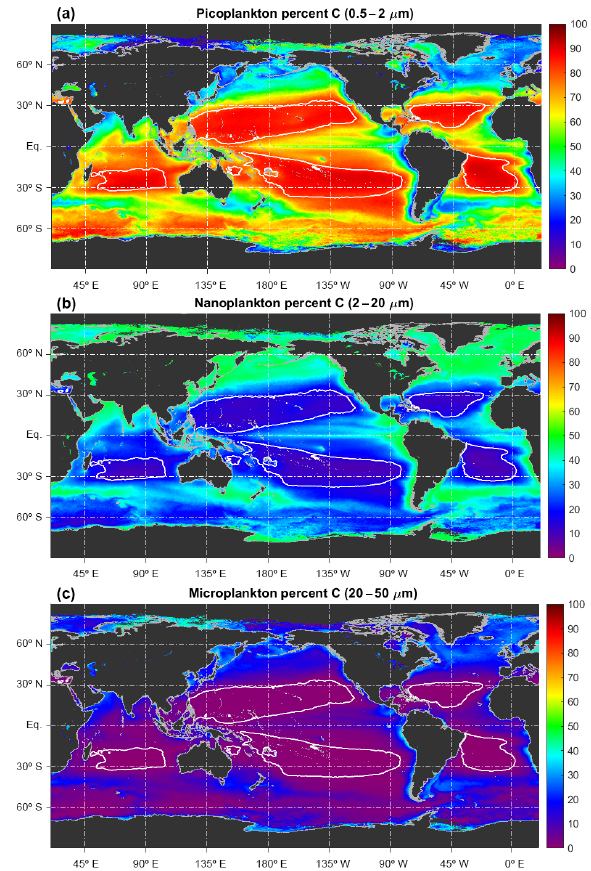
Figure 3. SeaWiFS mission composite (September 1997– December 2010) of size-partitioned phytoplankton carbon biomass, C (mgCm − 3 in log10 space) estimated with the PSD/allometric method for (a) picoplankton, (b) nanoplankton and (c) microplank- ton. The white contours are the 0.08mgm − 3 isoline of Chl. Note that the color scale is different from that of Fig. 1.